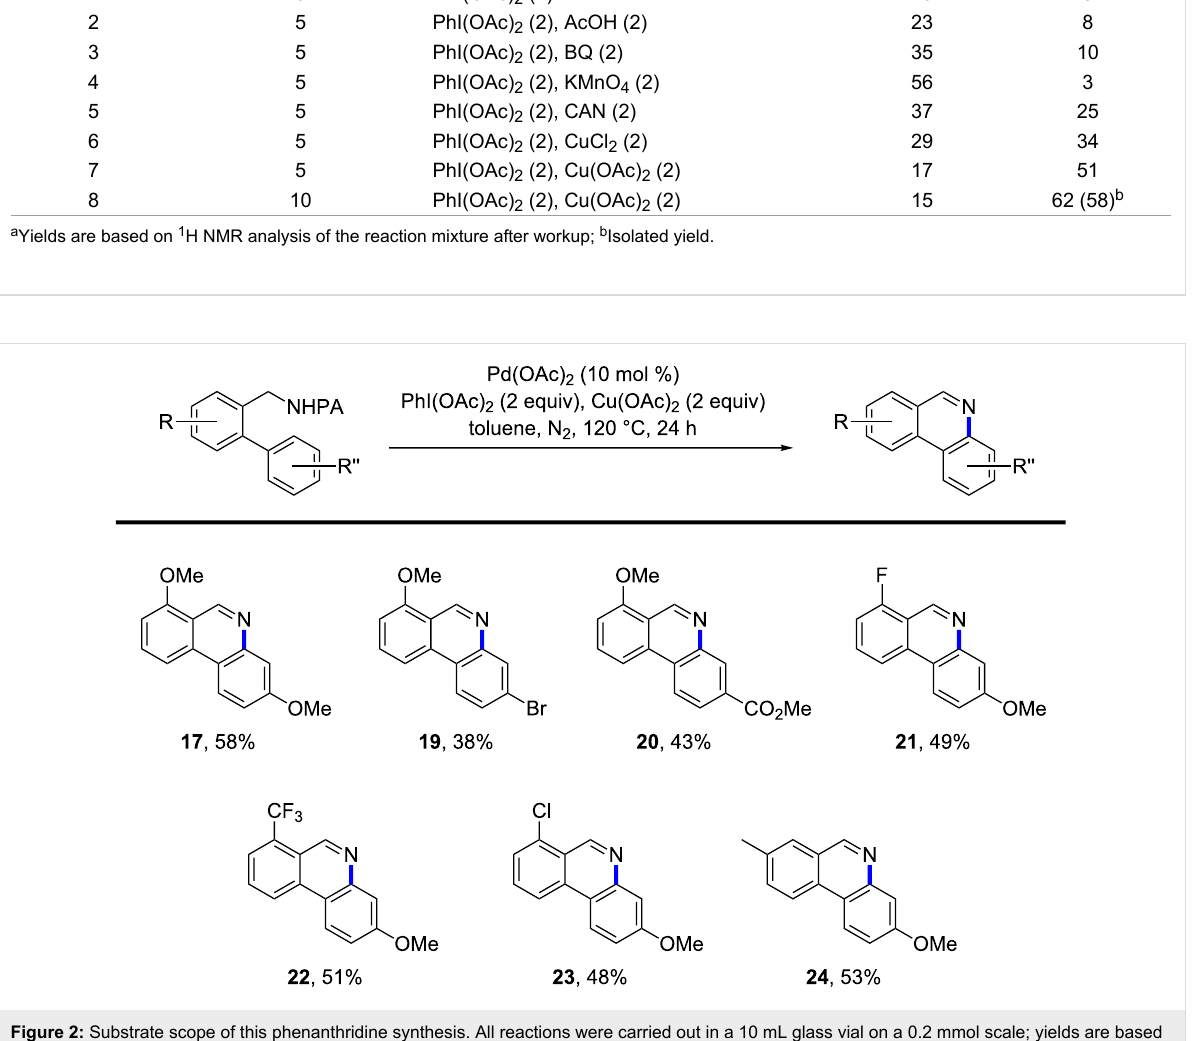
Pd(OAc) 2 affords phenanthridines in moderate to good yields. phenanthridines with novel photophysical properties are cur- rently